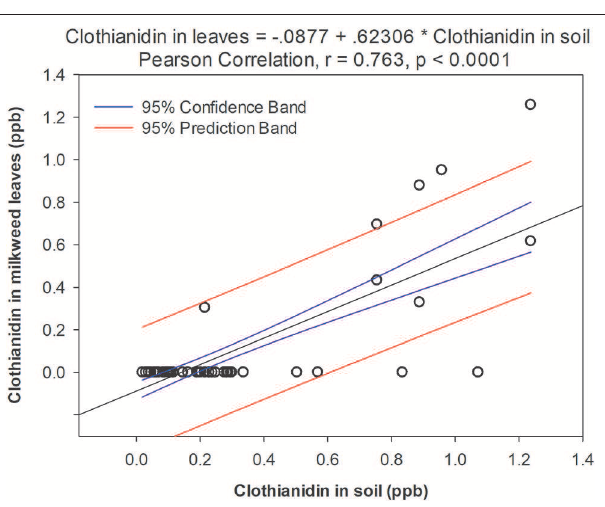
FIGURE 3 | Relationship between clothianidin concentration detected in soil and leaves from adjacent milkweed plants. Data points represent a paired soil-leaf sample for a given